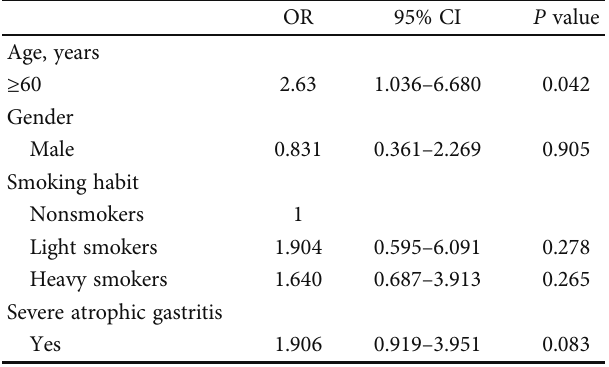
Table 2: Multivariate analysis of risk factors for